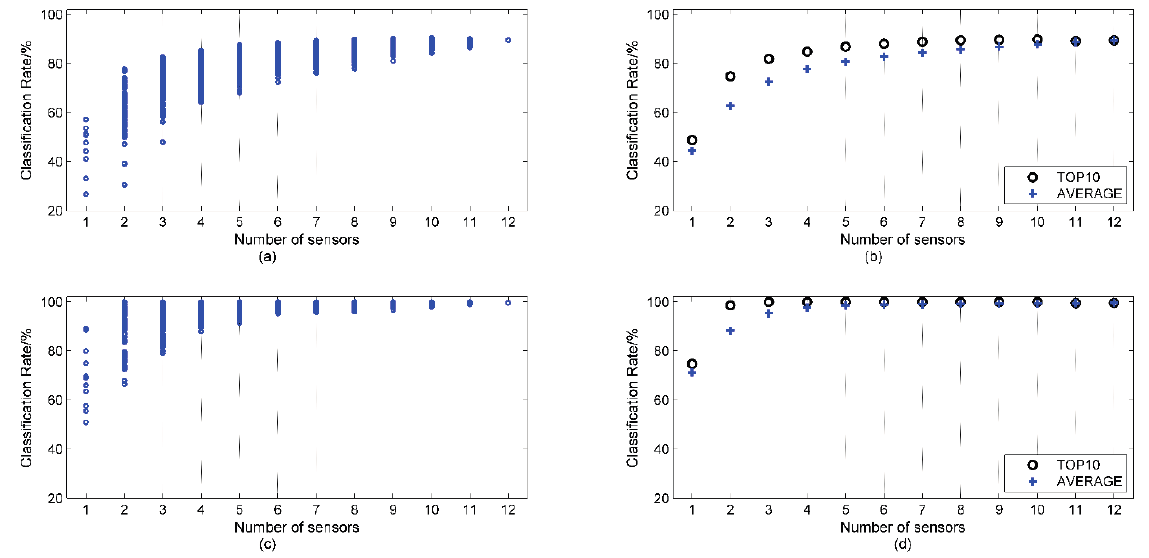
Figure 4. ( a ) Classification performance of sample set A1 with N (1 to 12) sensors; ( b ) Corresponding TOP 10 and AVERAGE value; ( c ) Classification performance of sample set A2 with N (1 to 12) sensors; ( d ) Corresponding TOP 10 and AVERAGE